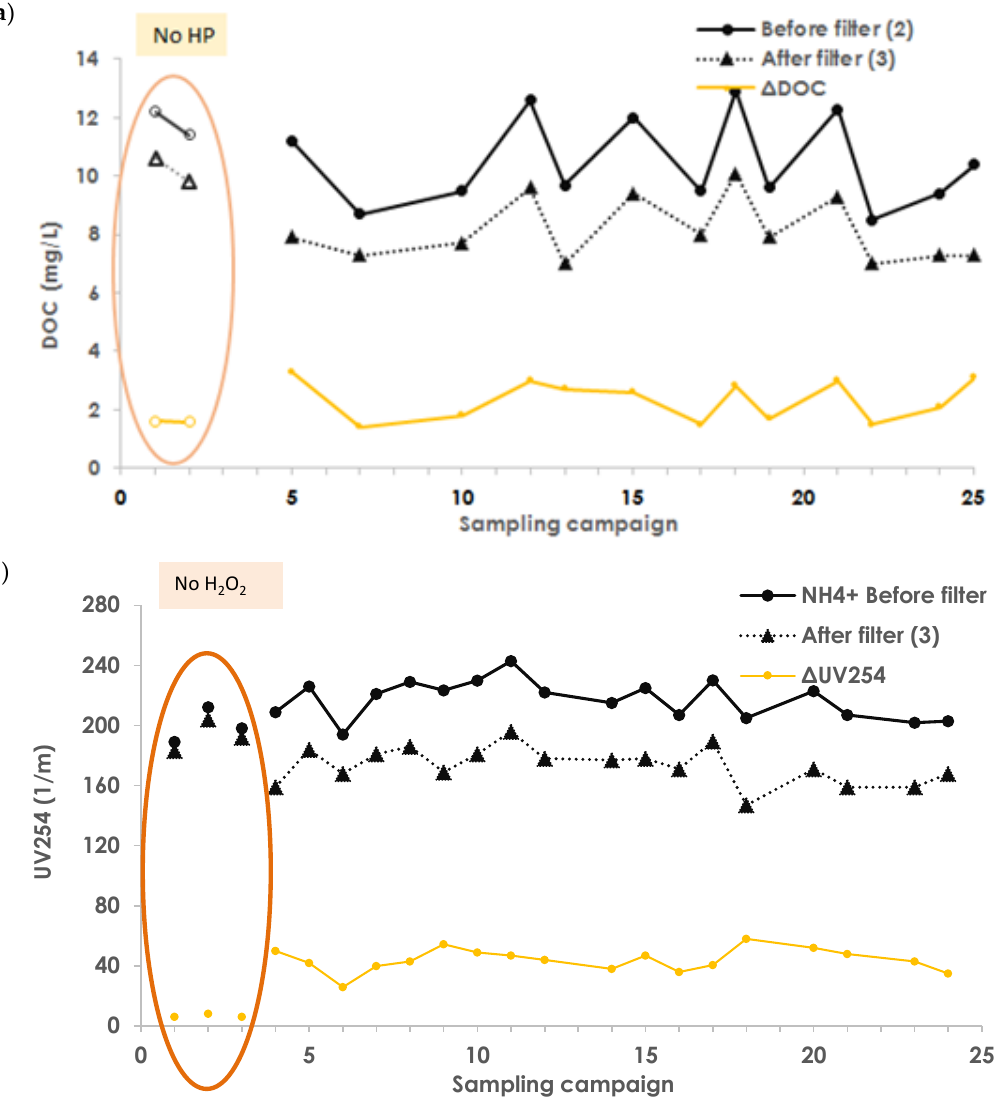
Figure A5. Concentrations and the removal of DOC ( a ) and UVA (UV 254 ) ( b ) over sampling campaigns before the biofilter (BF) and after the biofilter (AF), which was also sorted by feed values of ammonium during experiments with H 2 O 2 addition. Reference campaigns of no H 2 O 2 are circled in